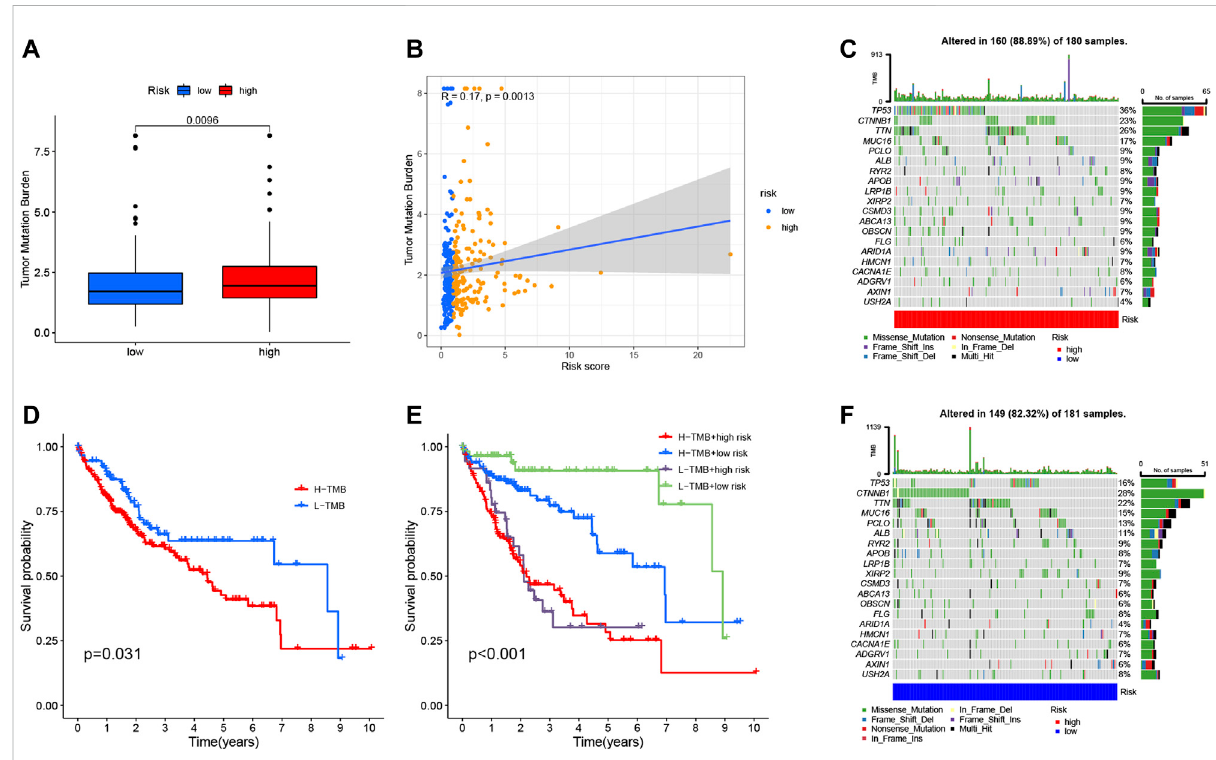
FIGURE 9 Correlation between risk score and TMB. (A) Differences in TMB between HRG and LRG. (B) Scatterplots depicting the positive correlation between risk scores and TMB. (D) Kaplan-Meier curves of high TMB and low TMB groups. (E) Kaplan-Meier curve strati fi cation of patients according to TMB and risk signature. The oncoPrint was constructed using high-risk score (C) and low-risk score (F)